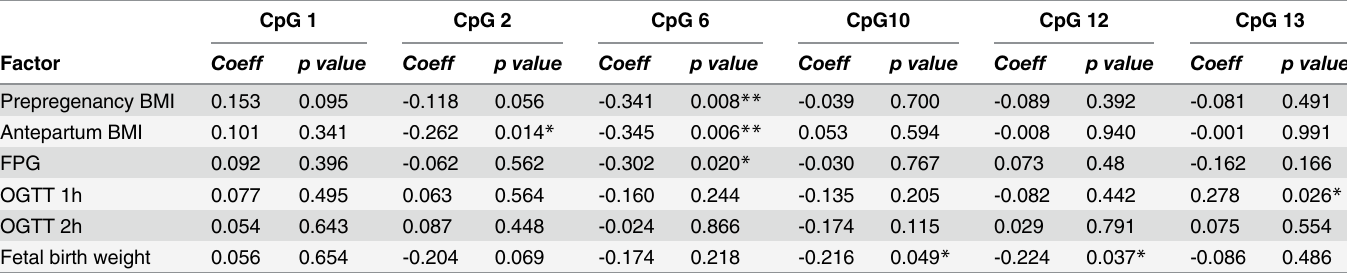
Table 4. Linear Regression of IGF2 Methylation on Fetal Birth Weight and Related Impact